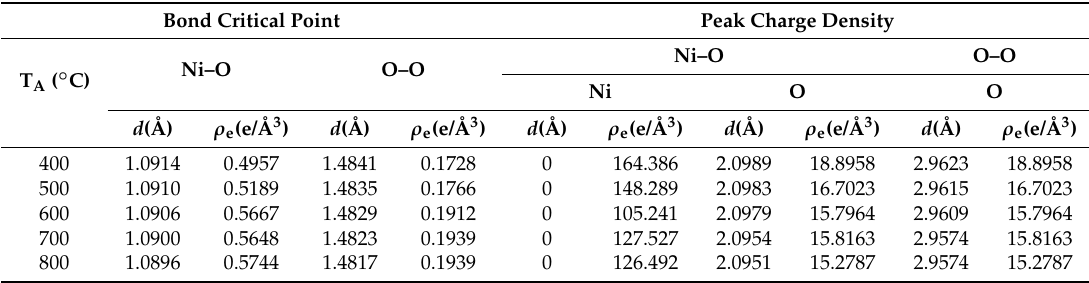
Figure 2. ( a ) Plot of the particle size dependence of the Ni–O bond length and ( b ) electron charge density ρ e at the critical point of Ni–O; ( c ) a plot of the one-dimensional charge density profile drawn between the Ni and O atoms at various annealing temperatures. Table 1. Peak charge density along the bonding directions of NiO ( d : distance, ρ e : electron density). Bond Critical